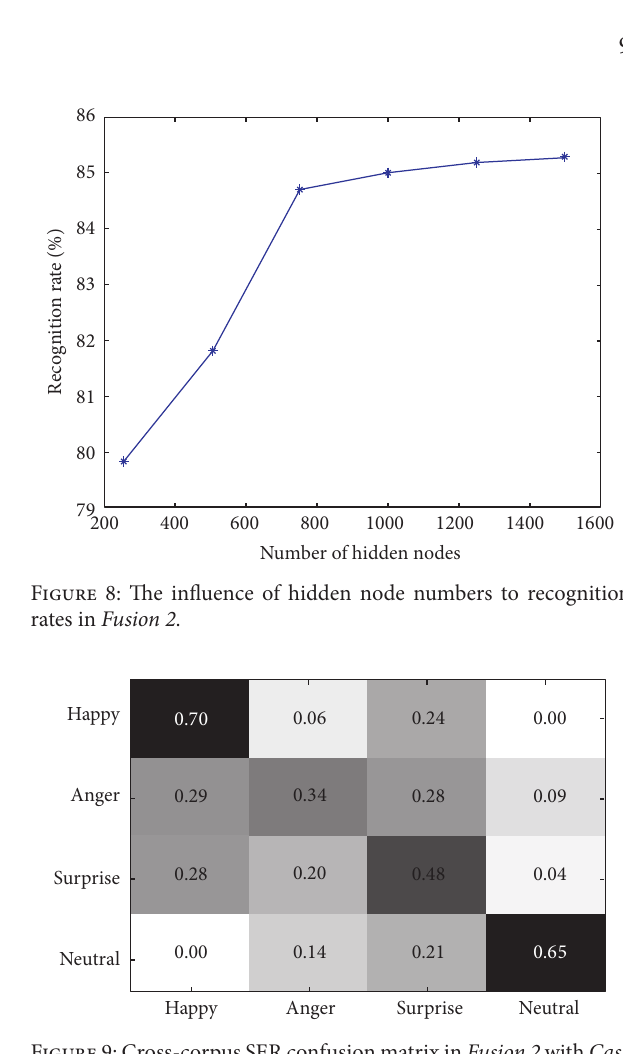
Figure 9: Cross-corpus SER confusion matrix in Fusion 2 with Case I